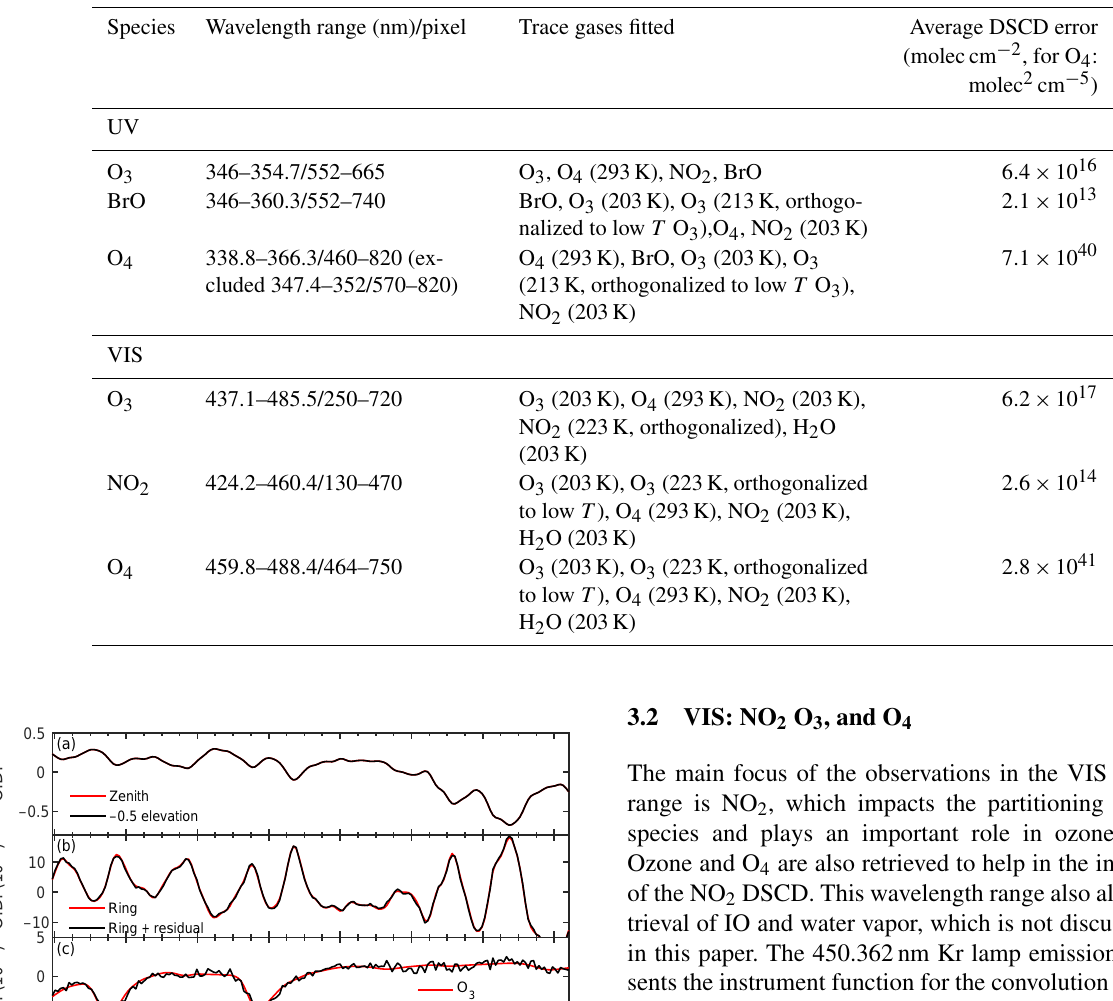
Table 4. Details of the spectral analysis of various trace gases.